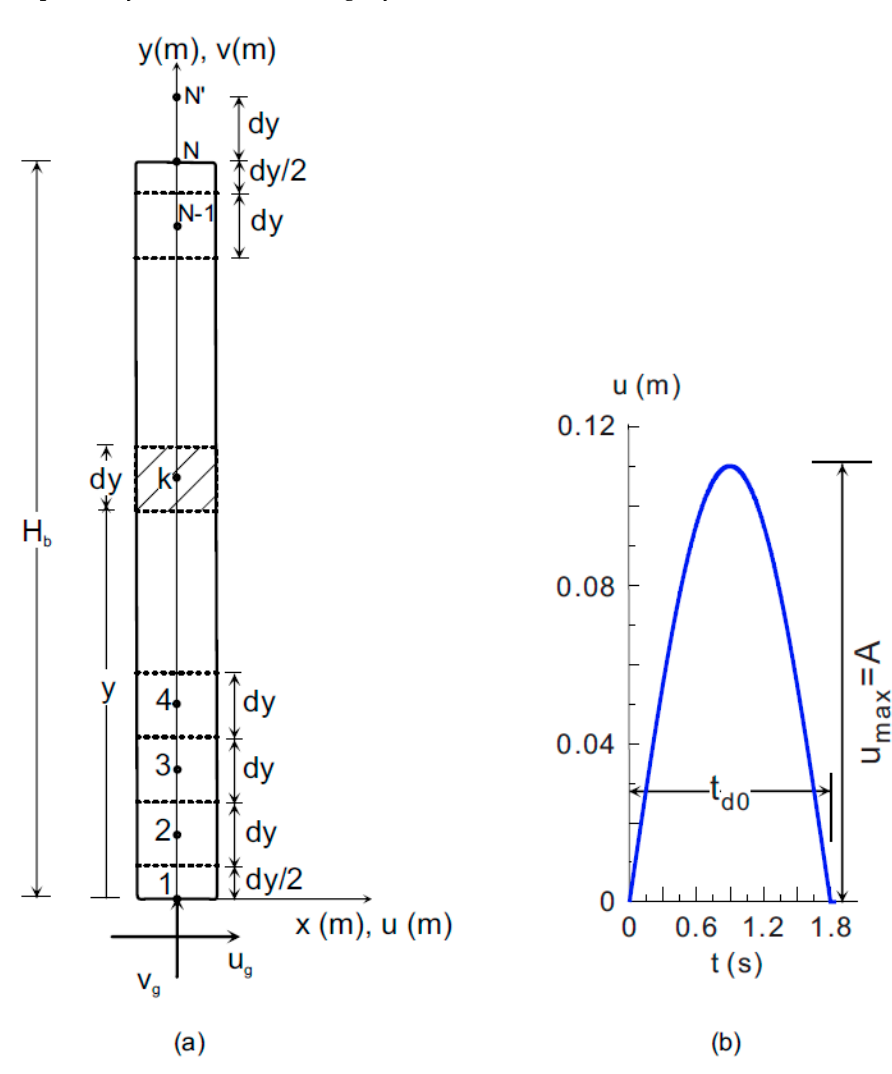
Figure 6. ( a ) The model, a shear building with a fixed base. ( b ) The input horizontal ground motion pulse.